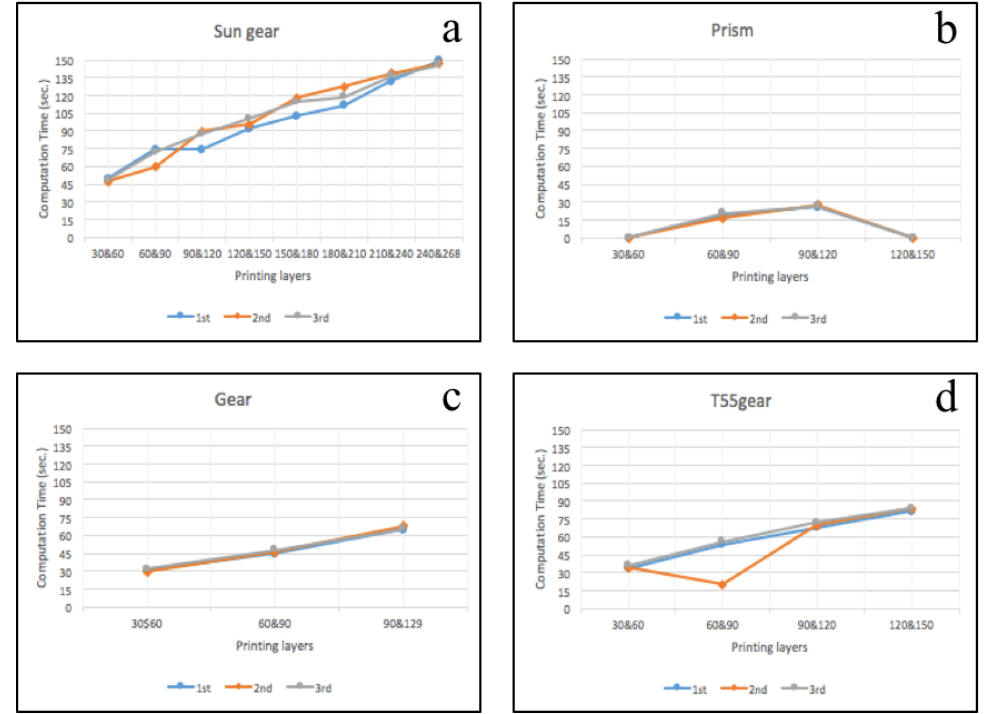
Figure 13. Image pre-processing—SIFT and RANSAC rescale and rectification: the computational time of failure state for ( a ) sun gear; ( b ) Prism; ( c ) gear; and ( d ) t55gear.